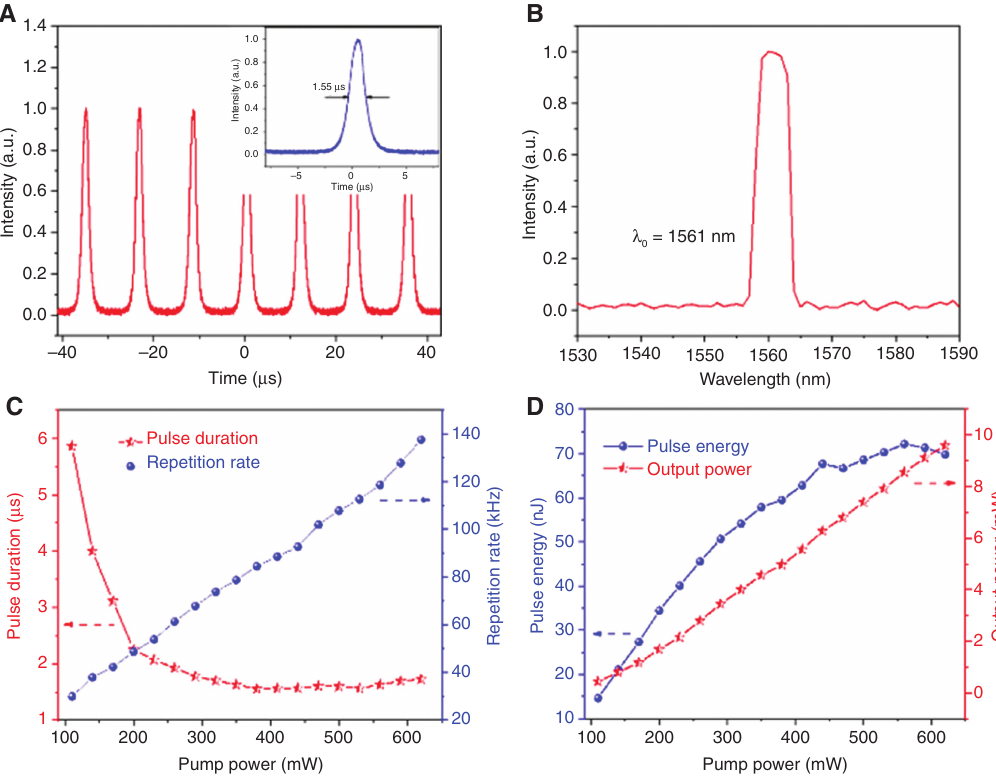
Figure 7: The results of Q-switched EDFL. (A) Q-switched pulse width at the pump power of 390 mW. (B) Optical spectrum. (C) Pulse repetition rate and pulse duration vs. pump power. (D) Single-pulse energy and average output power vs. pump